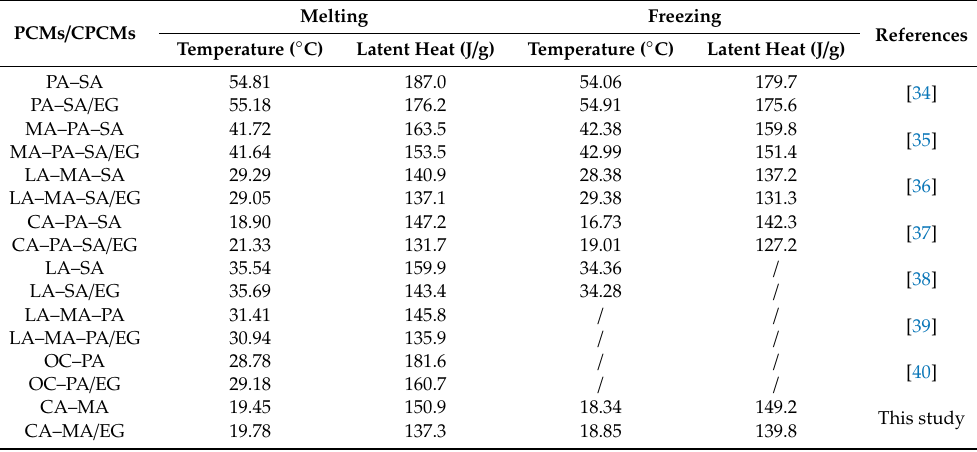
Table 1. Heat performances of some phase change materials (PCMs) and composite phase